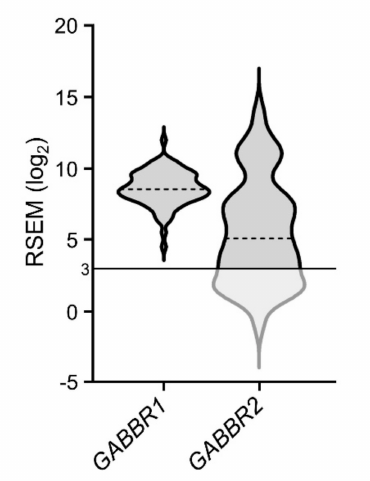
Figure 8. Expression of transcripts encoding GABA B receptor subunits; dotted lines represent median expression